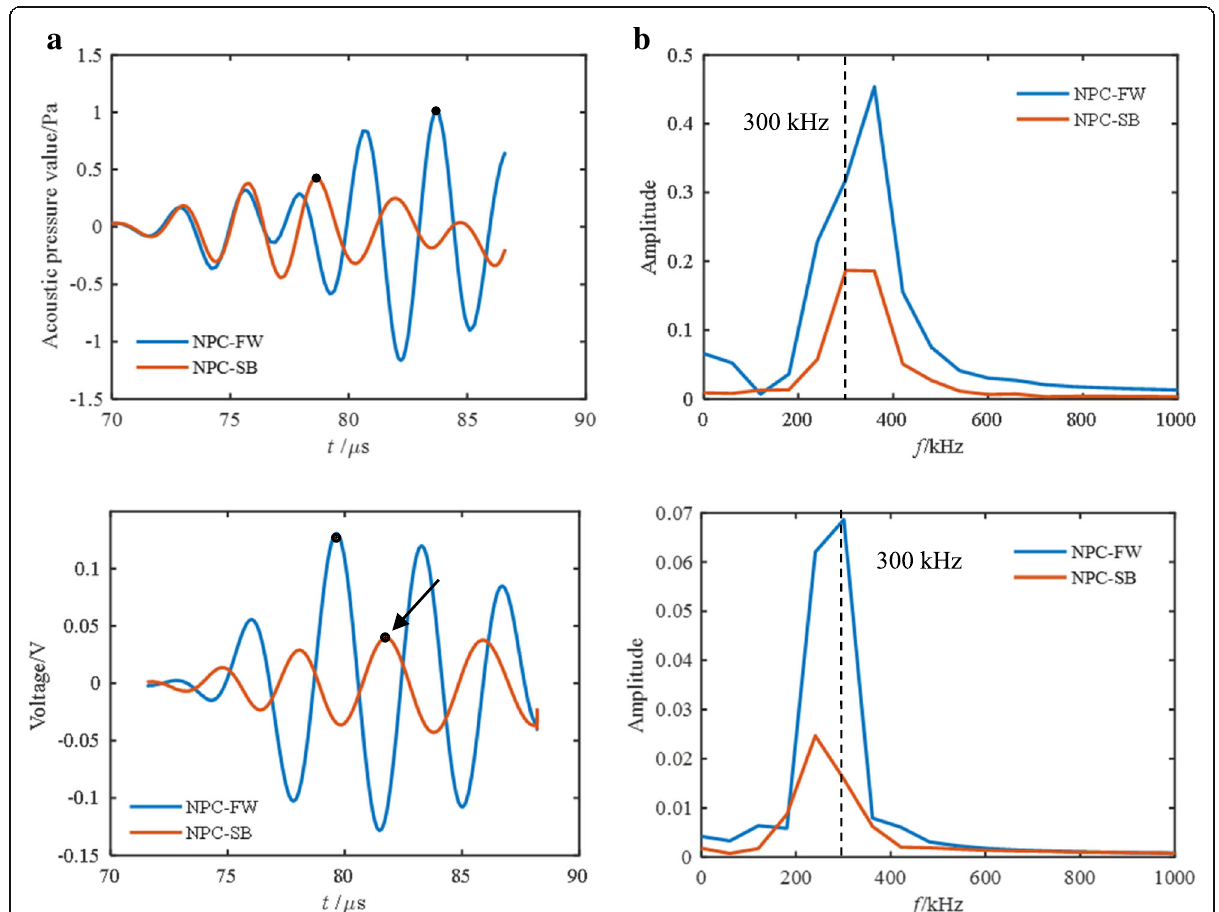
Fig. 6 A comparison of the received direct signal of ultrasound waves between NPC-FW and NPC-SB: a time domain signals of simulated and experimental results and b frequency domain signals of simulated and experimental results